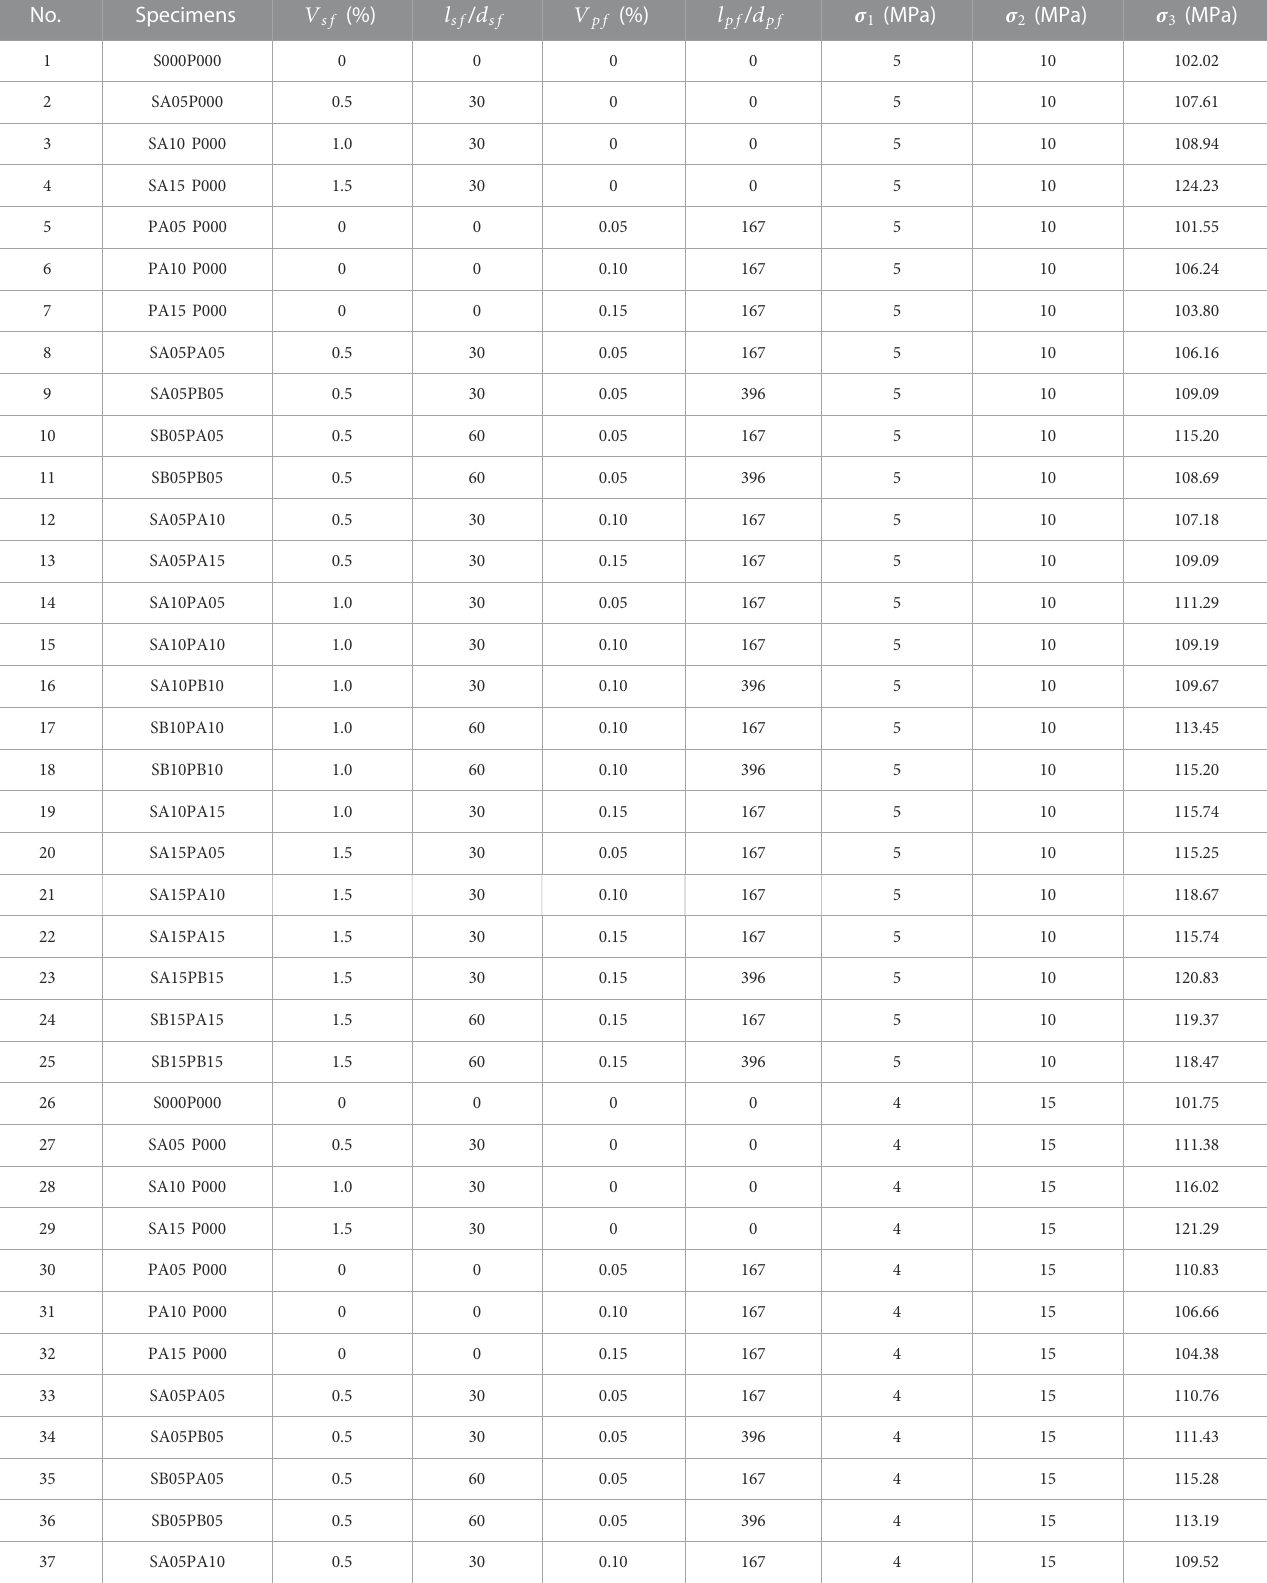
TABLE 4 Axial strength of HFRC under true triaxial